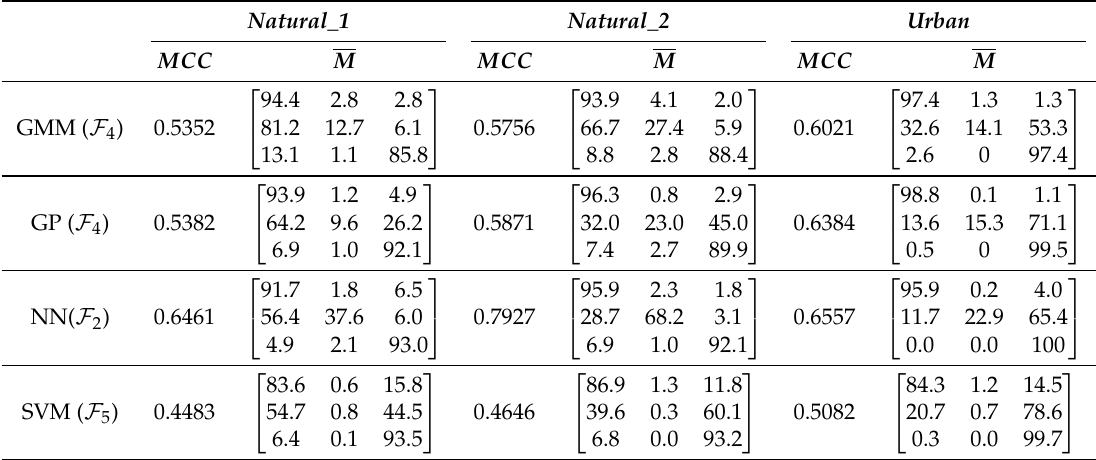
Table 4. Performance of classifiers ( MCC and M ) for the evaluation datasets using selected